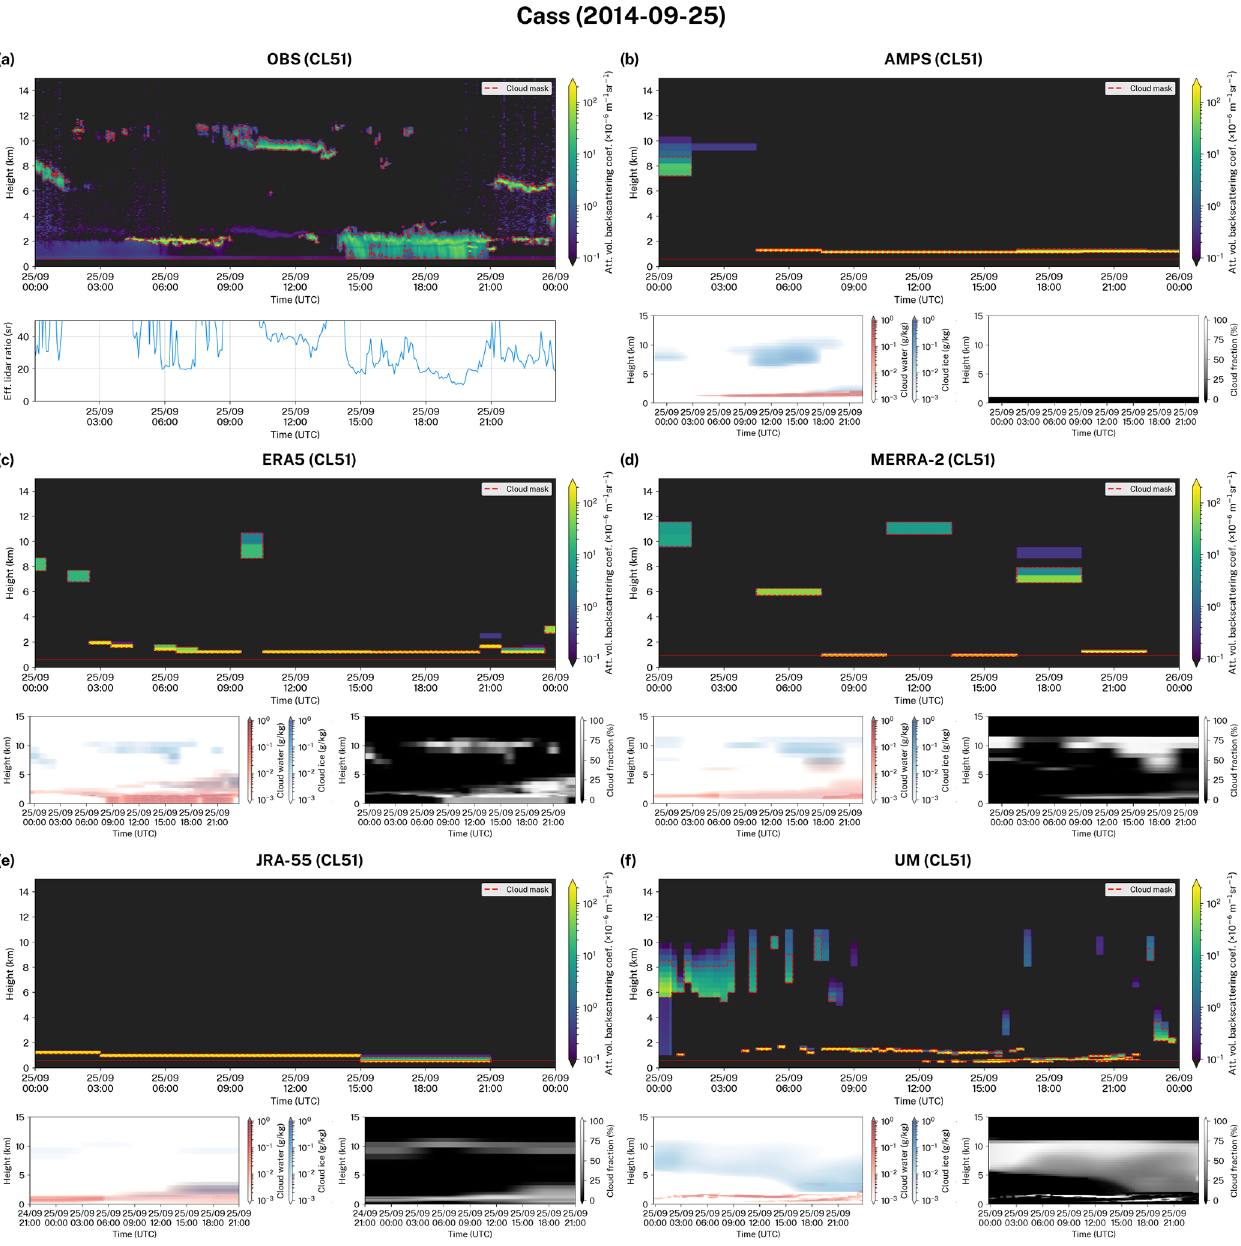
Figure 4. Examples of the observed and simulated attenuated volume backscattering coefficient during 24h at Cass. The observed attenuated volume backscattering coefficient was normalised to absolute units and denoised. The first subcolumn generated by the Subgrid Cloud Overlap Profile Sampler (SCOPS) was used to make the plots. The red line is the station altitude. S (a) The observed effective lidar ratio calculated by vertically integrating the attenuated volume backscattering coefficient is also shown, as are (b–f) the corresponding model cloud liquid water, cloud ice and cloud